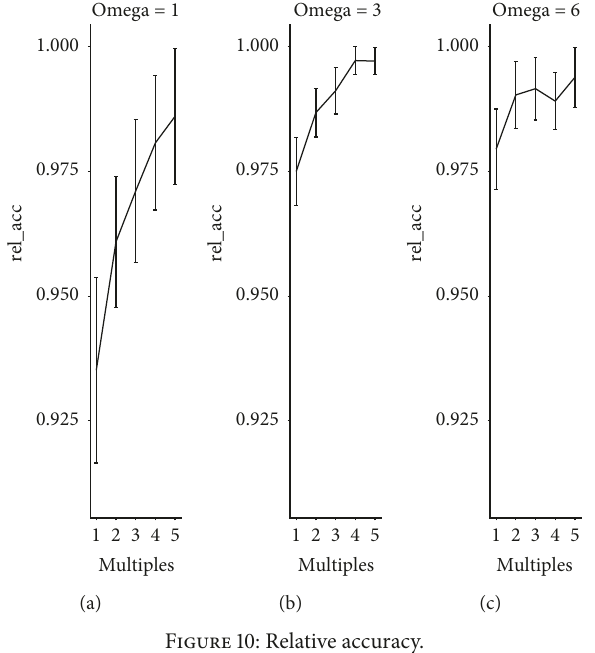
Figure 10: Relative